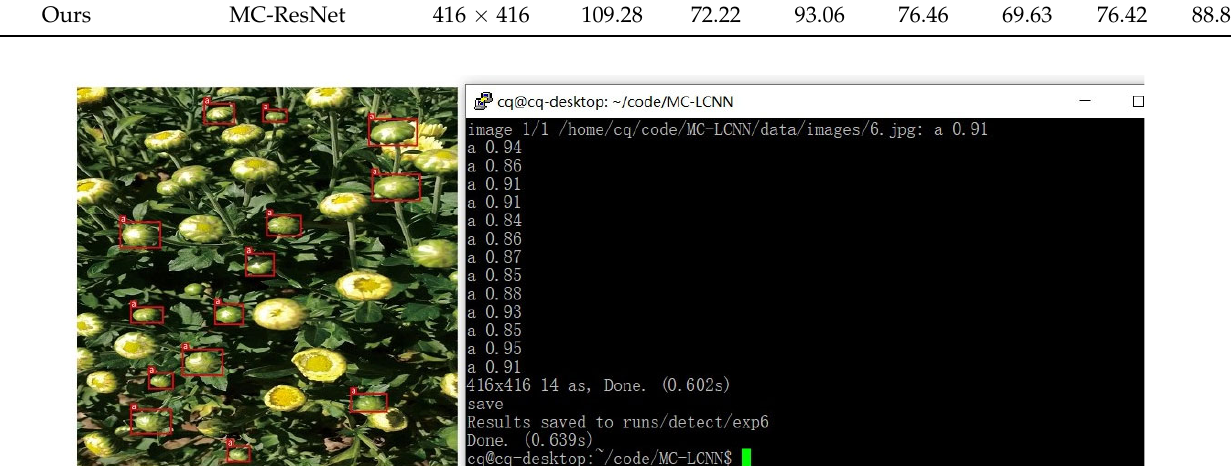
Figure 6. The test results on the NVIDIA Jetson TX2.